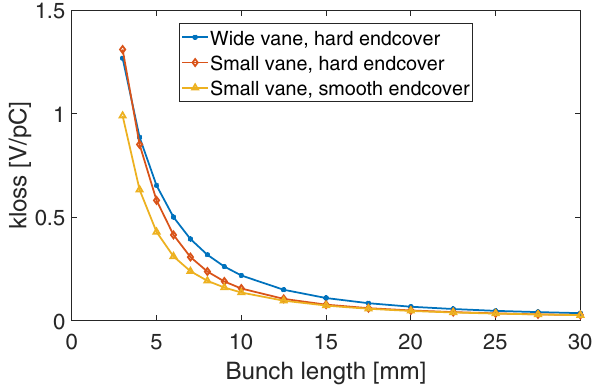
FIG. 7. Dependence of the loss factor on the rms bunch